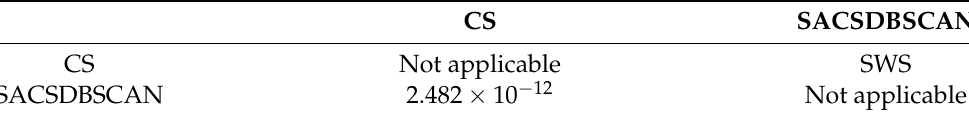
Table 19. p -values for instance